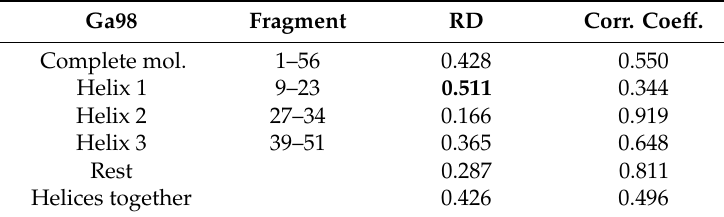
Table 2. List of parameters characterizing the status of the whole Ga98 protein and the highlighted sections representing a specific secondary structure. Bold— RD status di ff erent from idealized (discordant fragment). Ga98 Fragment RD Corr. Coe ff . Complete